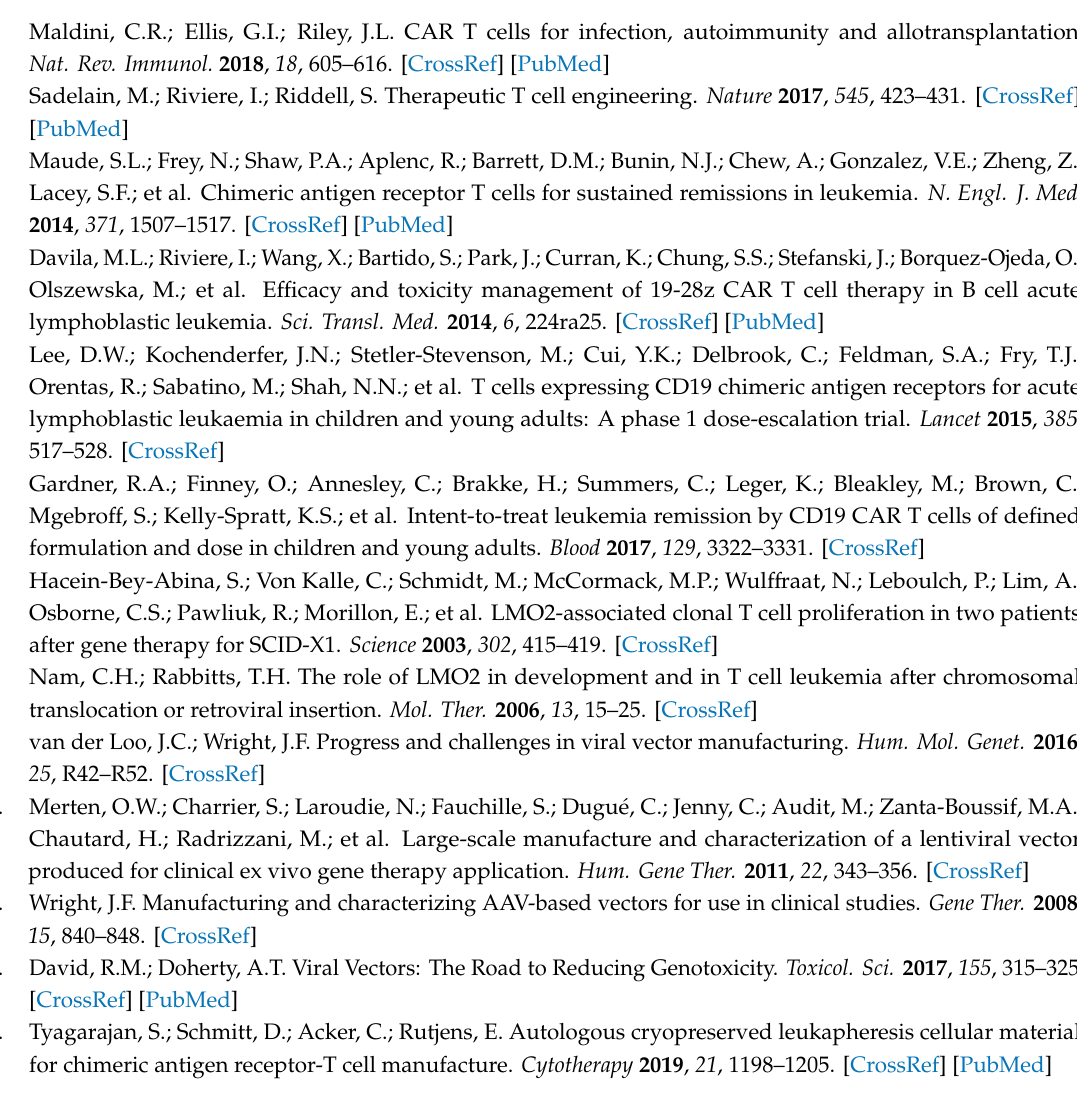
Figure S2. Applications of site-specific transgene integration using CRISPR-Cas9: (a) Successful knock-in of a CAR and a BiTE into the TRAC locus was confirmed by flow cytometry. For details on CAR and BiTE sequences, see Section 4.1.1. (b) IL-13 production is increased upon T-cell activation (-act, non-activated; + act, activated) ( n = 3). Knock-In Protocol: Table S1. Primer sequence for dsDNA template. Table S2. SgRNA sequences for TRC